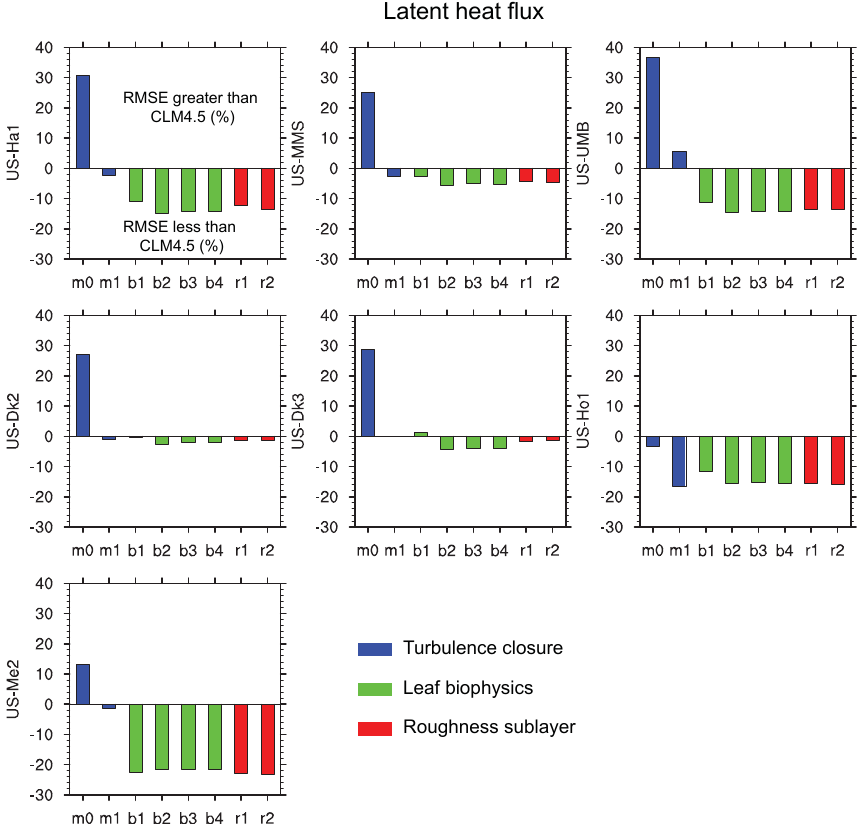
Figure 7. Root mean square error (RMSE) for latent heat flux for the eight simulations m0–r2. RMSE for each simulation is given as a percentage of the RMSE for CLM4.5 and averaged across all years at each of the seven forest sites. A negative value shows a reduction in RMSE relative to CLM4.5 and indicates model improvement. Changes in RMSE between simulations show the effect of sequentially including new model parameterizations as described in Table